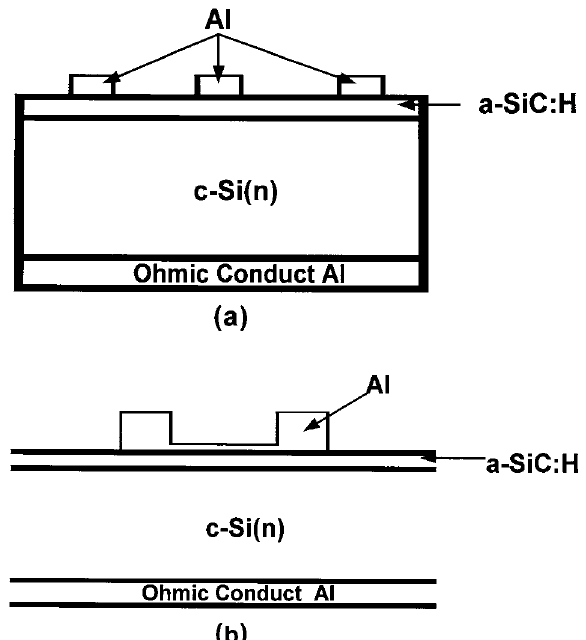
FIGURE 1 (a) Typical structure of the Al = a-SiC:H Schottky diode. (b) Typical structure used for the measurement of the spectral response of the Al = a-SiC:H Schottky